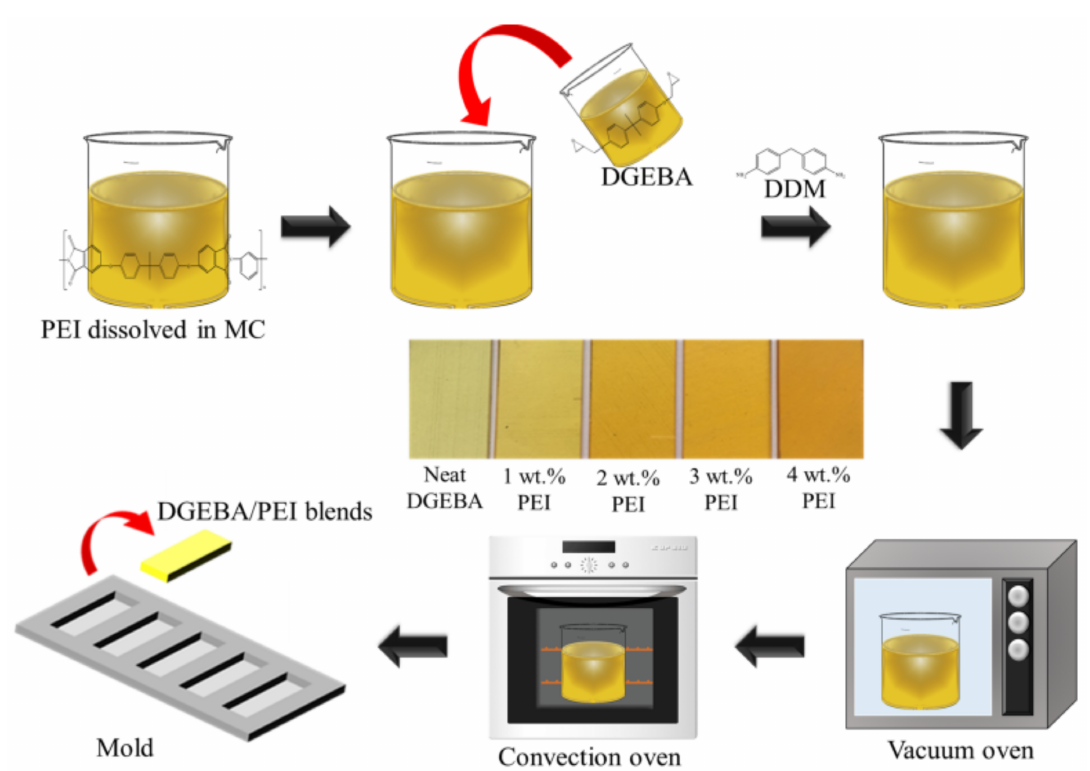
Figure 2. Schematic diagram for the preparation of DGEBA/PEI